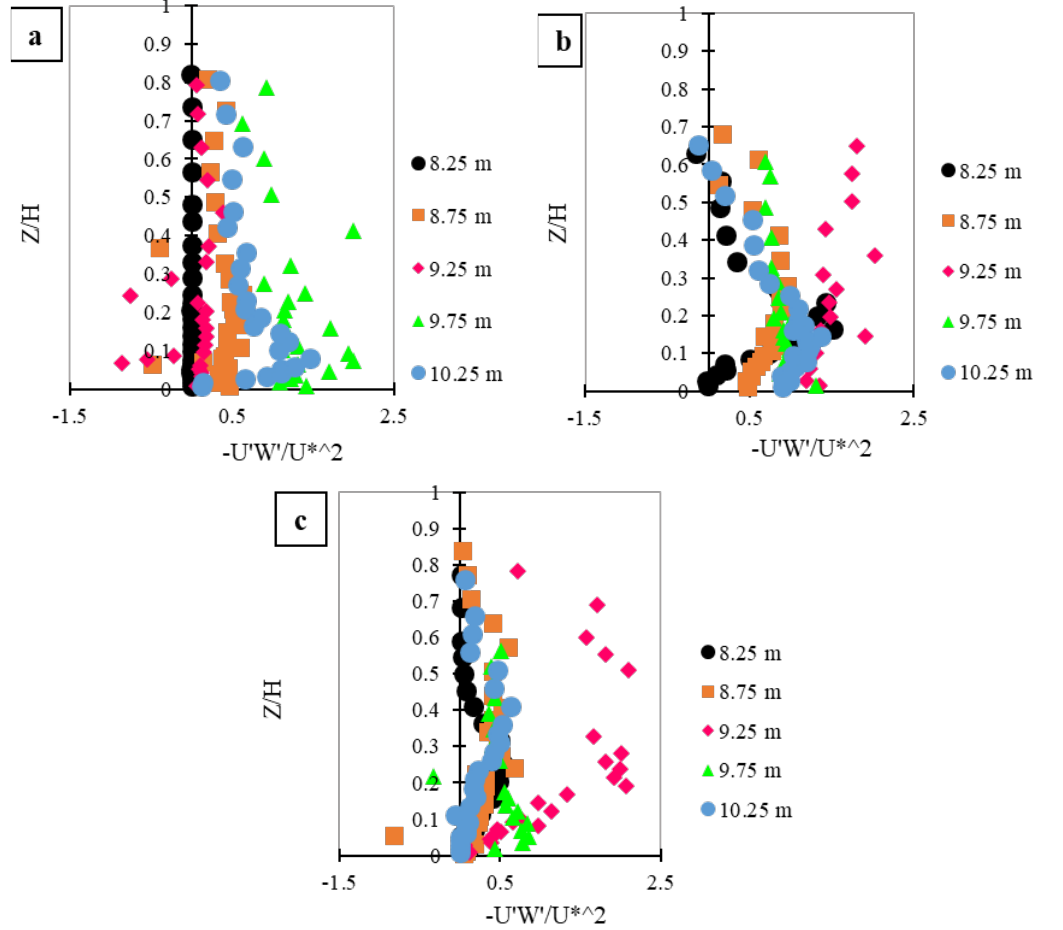
Figure 12. Reynolds stress profiles for: ( a ) series “ a ” test on the central axis of the channel with an angle of 5° and aspect ratio of less than five, ( b ) series “ b ” test on the central axis of the flume with an angle of 5° and aspect ratio of more than five, and ( c ) series “ c ” test on the central axis of the flume with an angle of 20° and an aspect ratio of less than five.